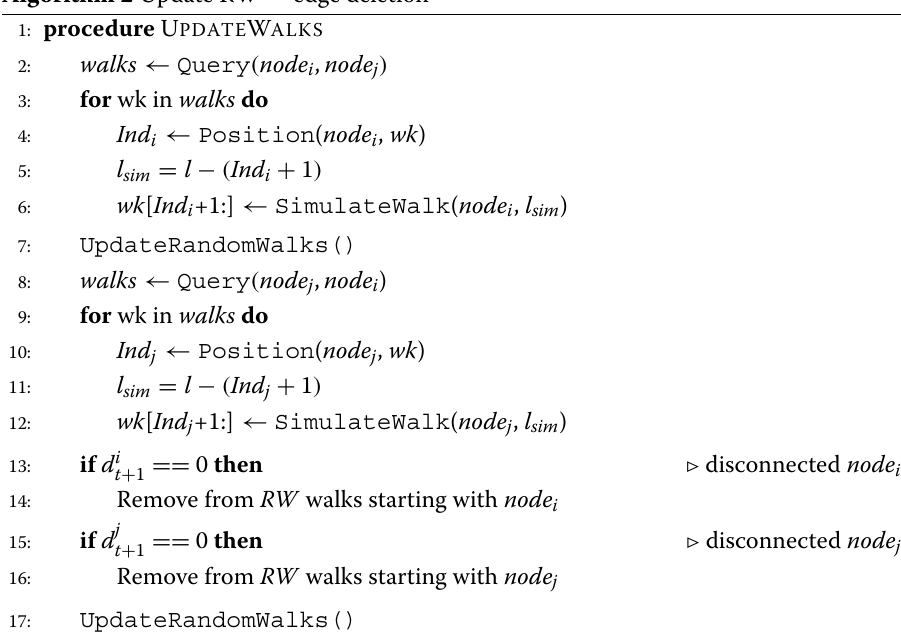
Algorithm 2 Update RW — edge